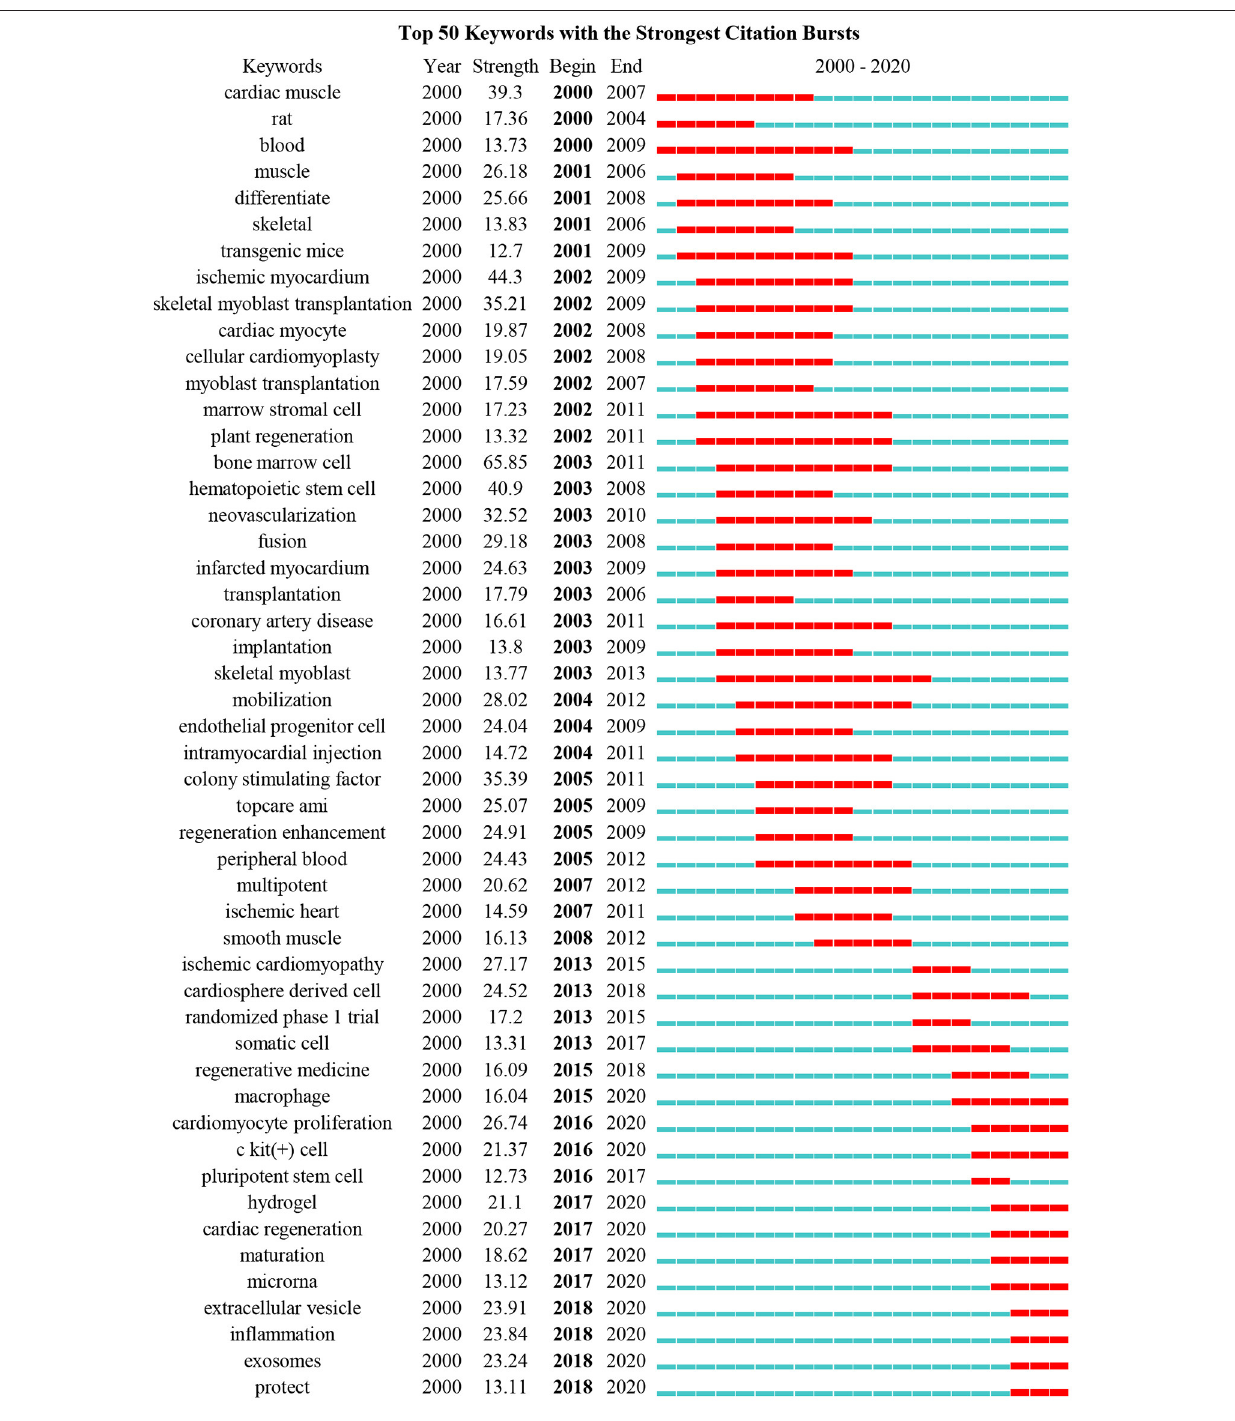
keywords, only two articles authored by Chong JJH and van Berlo JH were obtained with a burst strength of 47.24 and